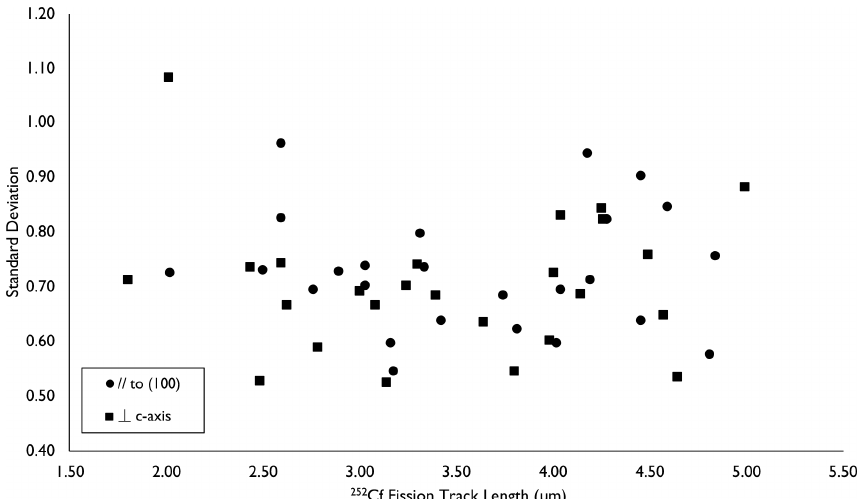
Figure 6. Standard deviation of 252 Cf fission track length distributions plotted against their average track lengths for both parallel and perpendicular surfaces across all